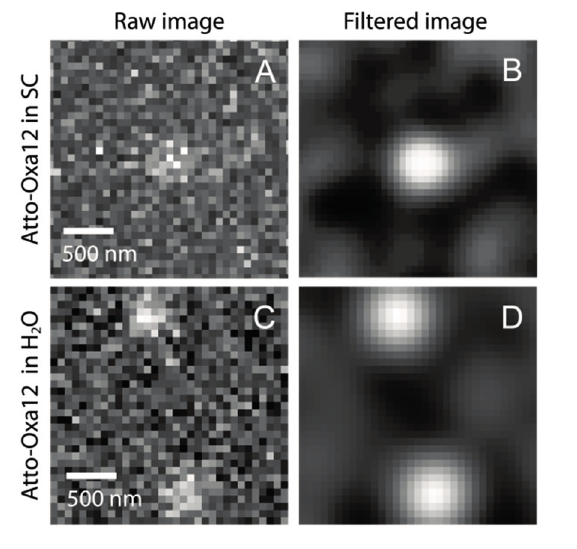
Figure 9. ( A ) TIRFM images of single Atto-Oxa12 molecules detected in the stratum corneum and in H 2 O: ( A ) individual raw image, showing an Atto-Oxa12 molecule in human SC; ( B ) Gaussian filtered image of ( A ); ( C ) Two single Atto-Oxa12 molecules in H 2 O are shown for comparison; ( D ) Gaussian filtered image of ( C